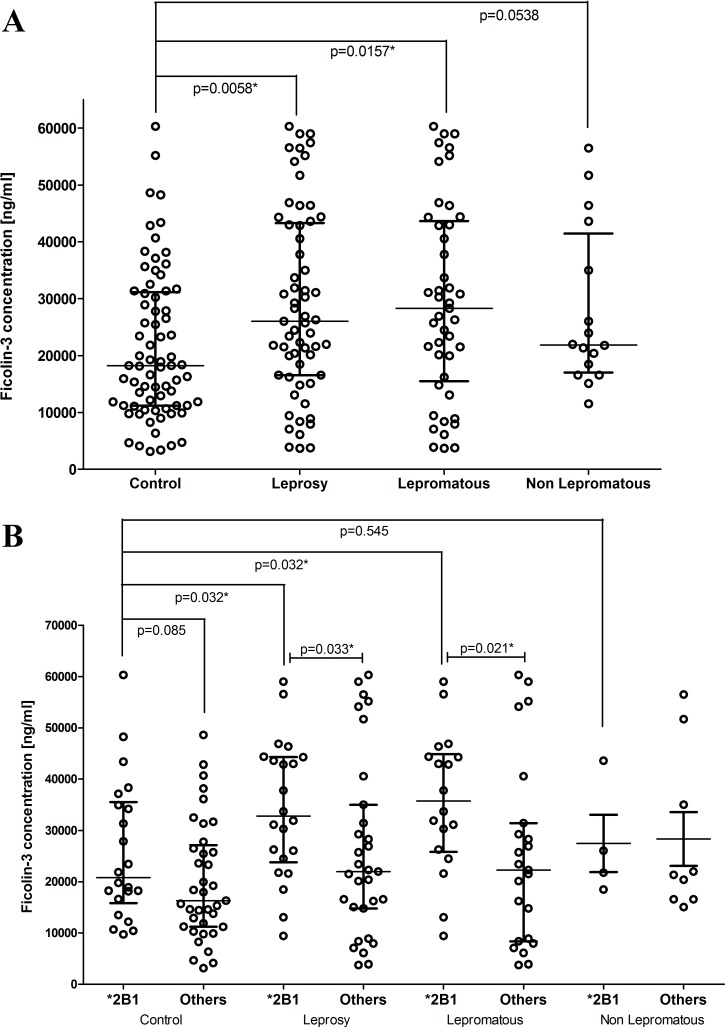
Distribution of Ficolin-3 levels in the investigated groups.Ficolin-3 levels in (a) the investigated groups and (b) in individuals with and without the FCN3 *2B1 haplotype. Comparisons were made using Mann-Whitney test. * indicates significant p values (<0.05). Bars indicate median and interquartile values.